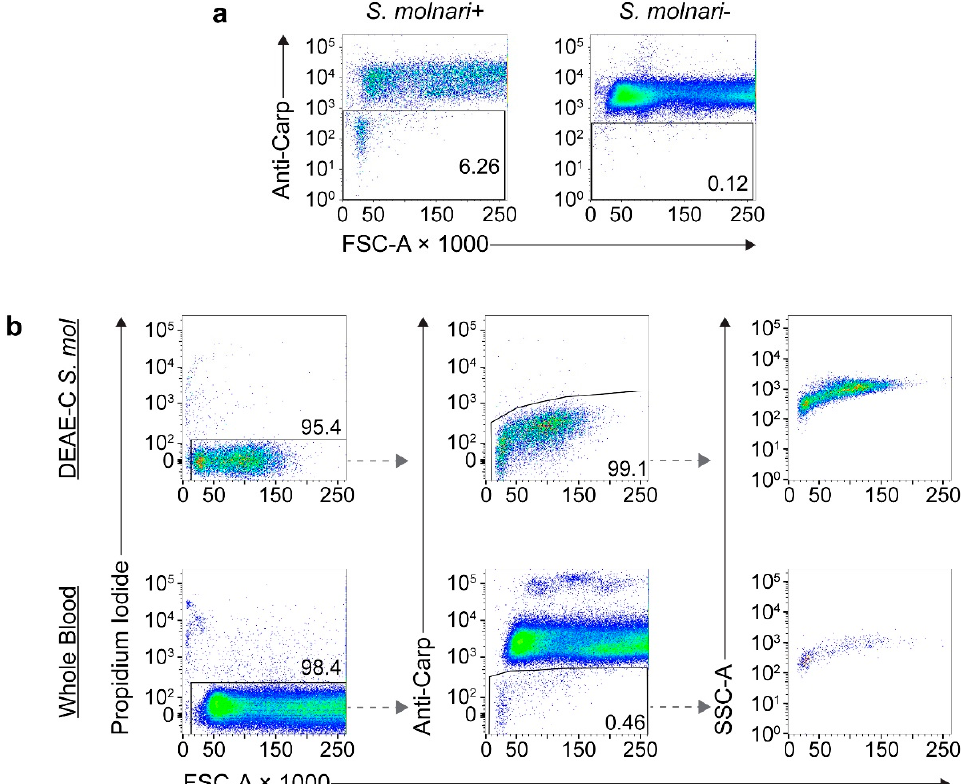
Figure 4. Flow cytometric approach for detecting and enumerating S. molnari BS using a negative labeling approach (all carp blood cells were labelled with the anti-pan-carp blood cell-APC/R-PE reagent [Anti-Carp]). ( a ) Quantification of BS in infected (+) vs. non-infected ( − ) whole blood. ( b ) Gating strategy for determining purity of S. molnari DEAE-C isolates (top row) and to quantify parasites in whole blood (bottom row). From left to right: First, only live cells (propidium iodide-negative) were gated (left); then, amongst these, parasites were detected by minimal reactivity to Anti-Carp (in this case 99.1% of the DEAE-C isolate and 0.46% of whole blood; middle); finally, we present side-scatter (SSC) and forward-scatter (FSC) profiles of BS isolates, that are comparable between pure parasite isolates from DEAE-C and in whole blood (right). Axes represent cell size (FSC), density/complexity (SSC) or fluorescence intensity (either of propidium iodide or of Anti-Carp staining). Dashed arrows illustrate step-wise gating and analyses of increasingly specific cell populations.